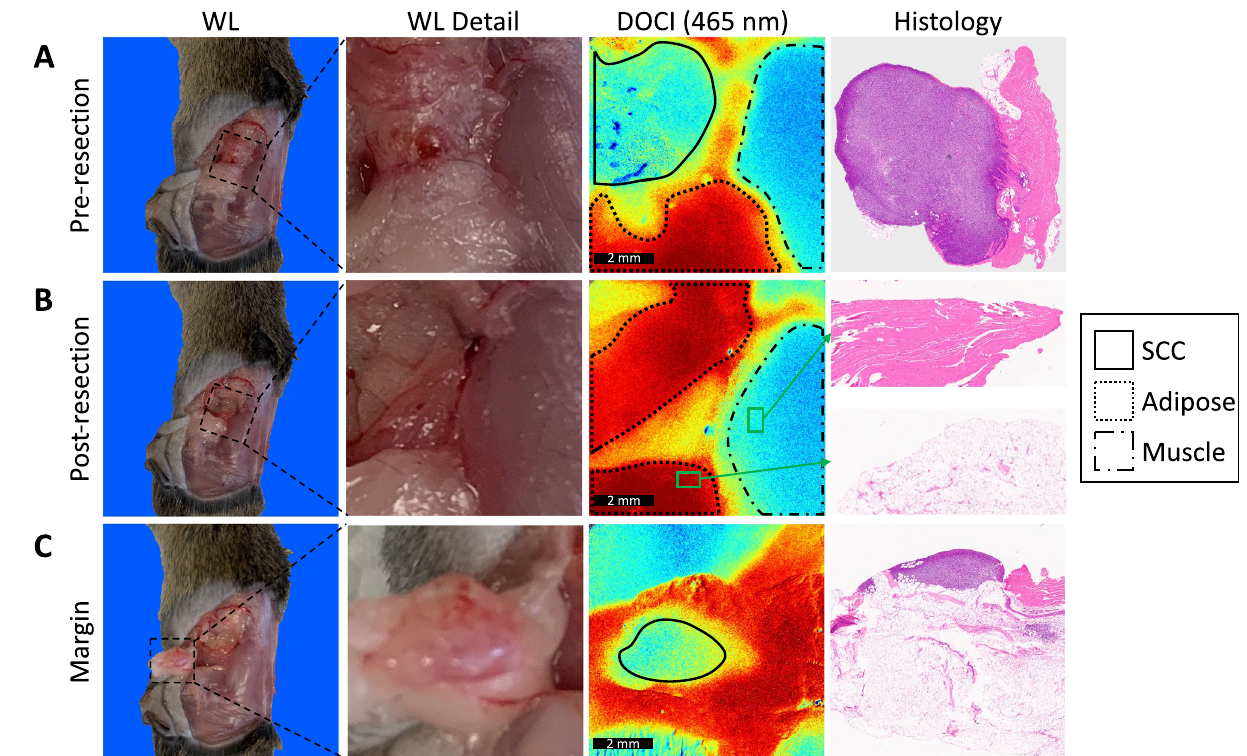
Figure 1. DOCI delineates margins between HNSCC and adjacent healthy tissue. ( A ) Prior to surgical resection of the tumor, DOCI was utilized to identify the tumor and determine margins. White light (WL) detail images and DOCI images were captured at a 1:1 ratio for direct comparison. Histology demonstrated HNSCC, concordant with DOCI imaging. ( B ) After resection, the tumor bed was imaged to identify any areas of tumor remaining. Histology taken from surrounding margins confirmed healthy adipose and muscle tissue (green inset). ( C ) DOCI imaging of margins revealed un-resected tumor along an adipose fat pad. Histology confirmed HNSCC with adjacent adipose fat. White light (WL), Dynamic Optical Contrast Imaging (DOCI), squamous cell carcinoma (Fig. 1A). DOCI imaging delineated the margins between HNSCC (green), compared to muscle (blue) and adipose tissue (red). Permanent histology of the tumor and adjacent healthy tissue was concordant with DOCI imaging (Figs. 1A,B). Following resection, the margins surrounding the tumor bed were re-imaged, revealing a 3 mm foci of remaining tumor inferior to the tumor bed (Fig. 1C). DOCI was able to direct further resection in this area, where the tumor was not appreciated by the surgeon’s visualization or palpation. The average relative lifetimes of different tissue types as a function of wavelength are shown in Fig. 2A. Each tissue type—including muscle, dermal adipose tissue (DAT), adipose tissue, nerve—has a unique DOCI value and trend relative to HNSCC. Overall, the 465 nm BPF shows the greatest contrast between tissues (Fig. 2A). P values were calculated for the DOCI values of each tissue type compared to SCC across all BPFs (Fig. 2B). DOCI accurately identifies perineural invasion. After validating that DOCI can delineate HNSCC margins in our in vivo murine model, we investigated the capacity of DOCI to identify PNI. DOCI images from sciatic nerves injected with PBS were compared to sciatic nerves injected with SCC7 (Fig. 3). Control nerves had higher relative lifetimes (white arrowheads) that were consistent along the entire length of the nerve. In contrast, portions of the nerve with perineural invasion had lower relative lifetimes (black arrowheads) compared to both the control nerve as well as healthy nerve adjacent to the tumor (grey arrowheads). Histology is concordant with DOCI imaging and also demonstrates the transition point between normal nerve and PNI. Control nerves had an average diameter of 0.81 mm. PNI+ nerves had a diameter ranging from 0.91 to 2.36 mm; there was a positive correlation between post-operative day and diameter of the PNI+ portion of the nerve. Mouse hindlimb func- tion was intact in all mice after injection. The average relative lifetimes of several regions of interest including control and PNI+ nerve are shown in Fig. 4A. Healthy nerve adjacent to tumor (PNI−) is plotted separately from the control nerve (PBS) but shows no statistically significant difference across all wavelengths (Supplementary Table 1). The P values of the differ- ent tissue types compared to PNI+ nerve are displayed in Fig. 4B as a Manhattan plot. In all BPFs, there was a statistically significant difference in DOCI values between the control and PNI+ nerves (Fig. 4B).